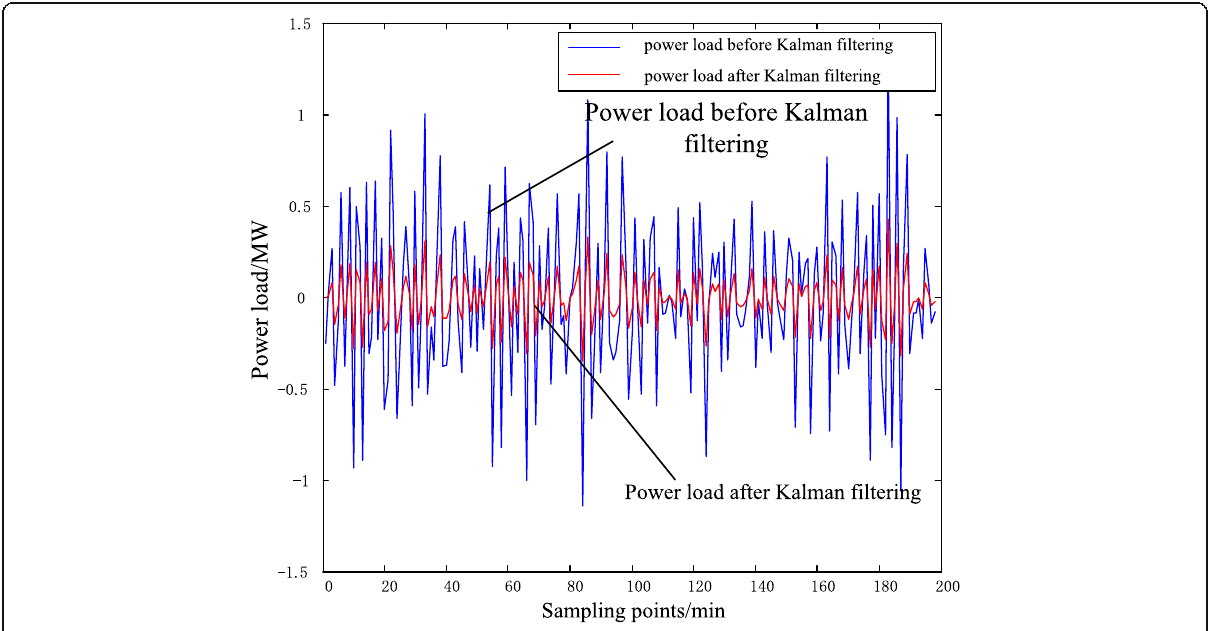
Fig. 4 Electric power load data comparison before and after Kalman filtering